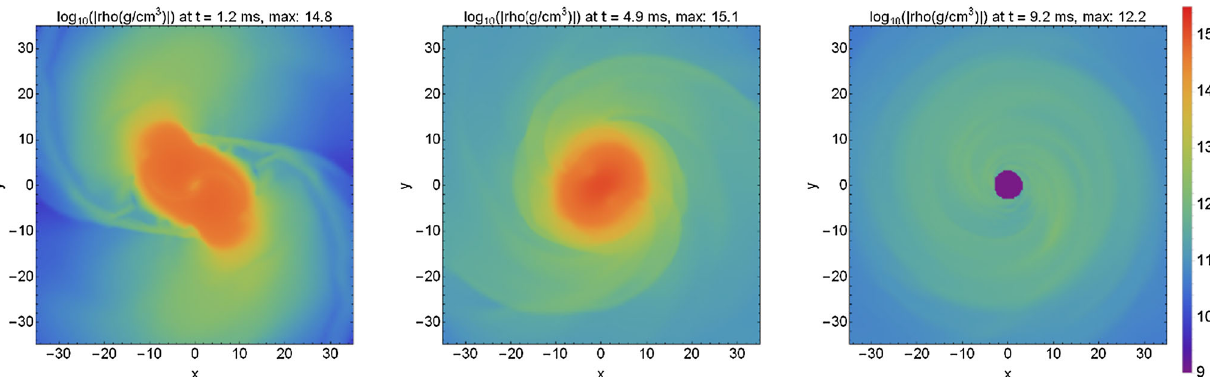
Fig. 21 Snapshots of the rest mass density profile of the merging neutron stars (both having the mass M = 1 . 4 M (cid:3) ) in the plane of rotation. Left: Density right after merger. Middle: Hypermassive neutron star about 5 ms after the merger. Right: Mass distribution right after black hole formation